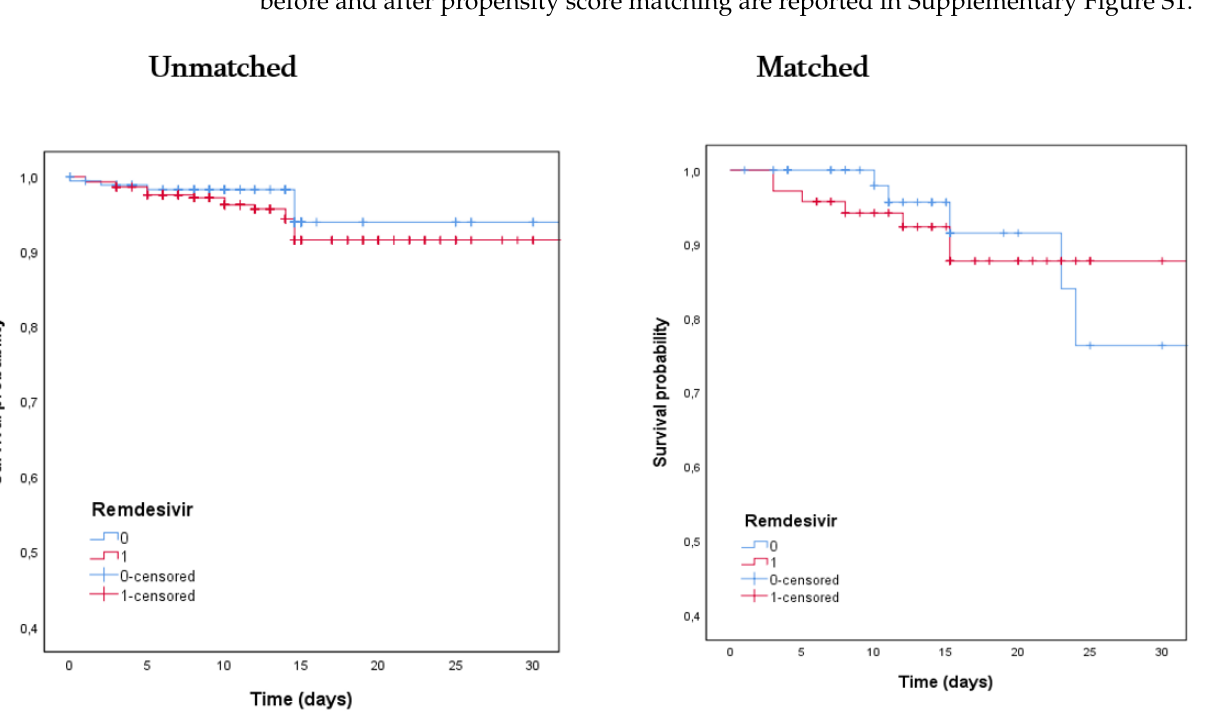
Figure 1. Kaplan – Meier curves for 30-day survival of patients treated with remdesivir (red line) or not (blue line) before ( p = 0.24) and after ( p = 0.88) propensity score matching.